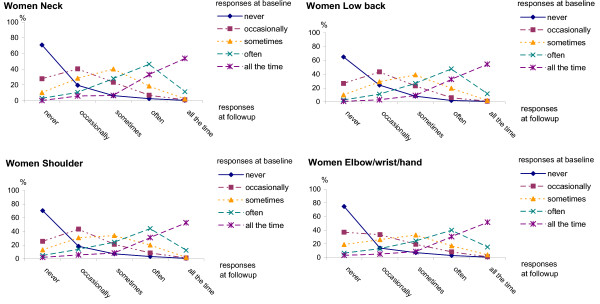
The course of reported symptoms among women; the reported symptoms at baseline and the transition in percentage at the one year follow-up.